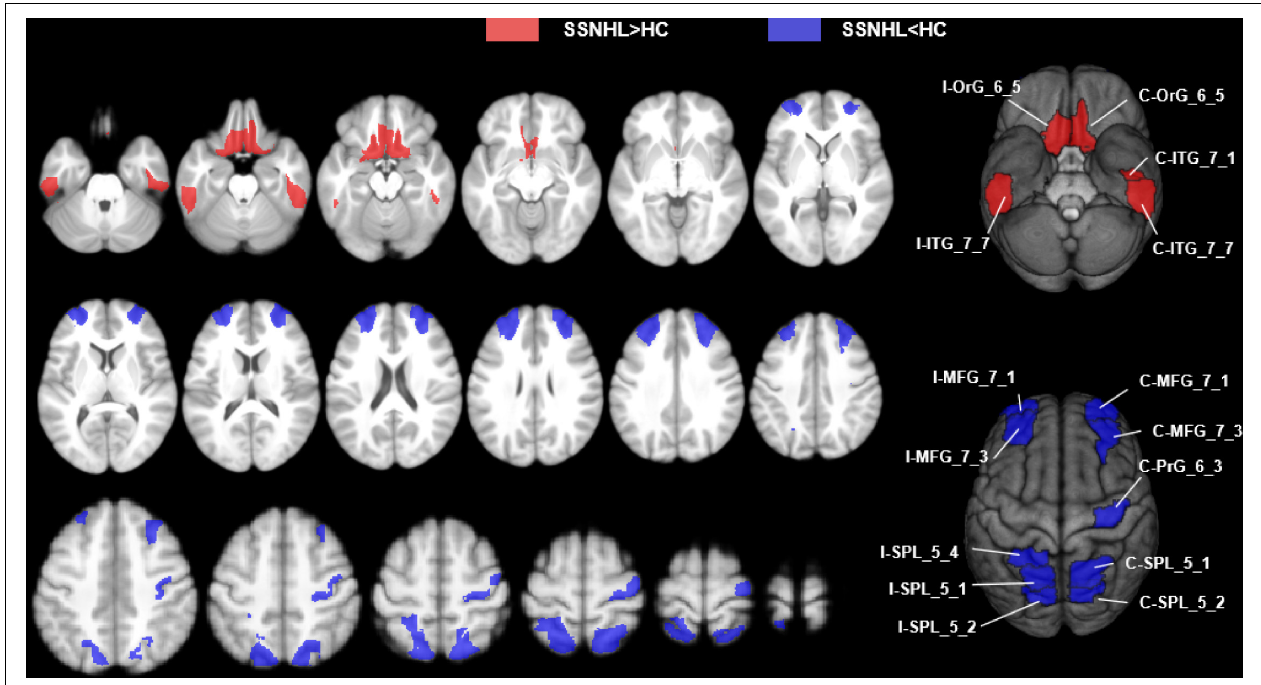
FIGURE 4 | Abnormal CBF subregions in patients with unilateral SSNHL compared with healthy controls. Red, SSNHL (rCBF) > HC (rCBF); Blue, SSNHL (rCBF) < HC (rCBF). I, ipsilateral; C, contralateral; MFG, middle frontal gyrus; PrG, Precentral Gyrus; SPL, superior parietal gyrus; ITG, inferior temporal gyrus; OrG, orbital